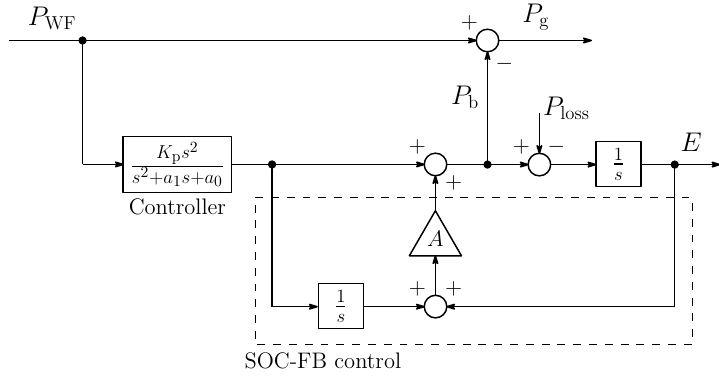
Figure 3. ESS control